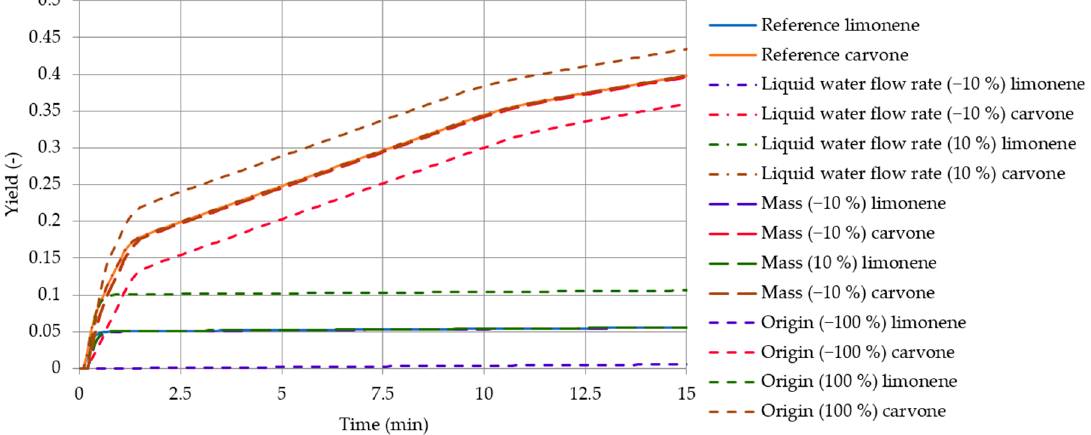
Table 4. Considered range and influence of model parameters for the Pareto diagram. SLE: solid– liquid extraction; LLE: liquid–liquid extraction.